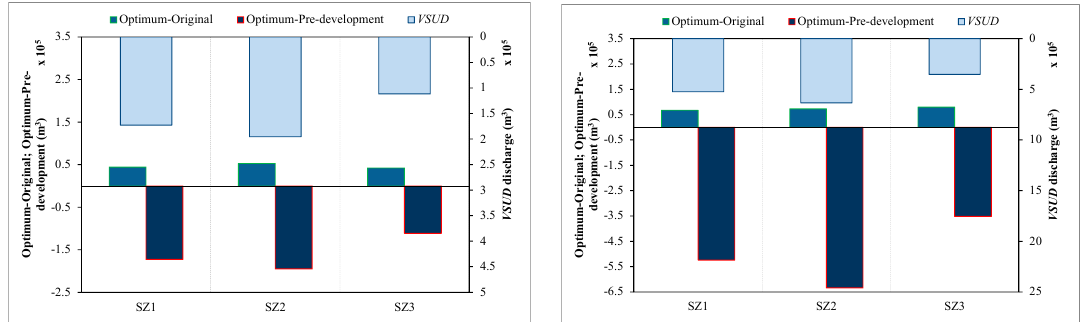
Figure 7. The difference of discharged volume to CUD between optimal SUDs combination and either the original or the predevelopment situation for a 5 ( left ) or 100 ( right ) return period storm events.